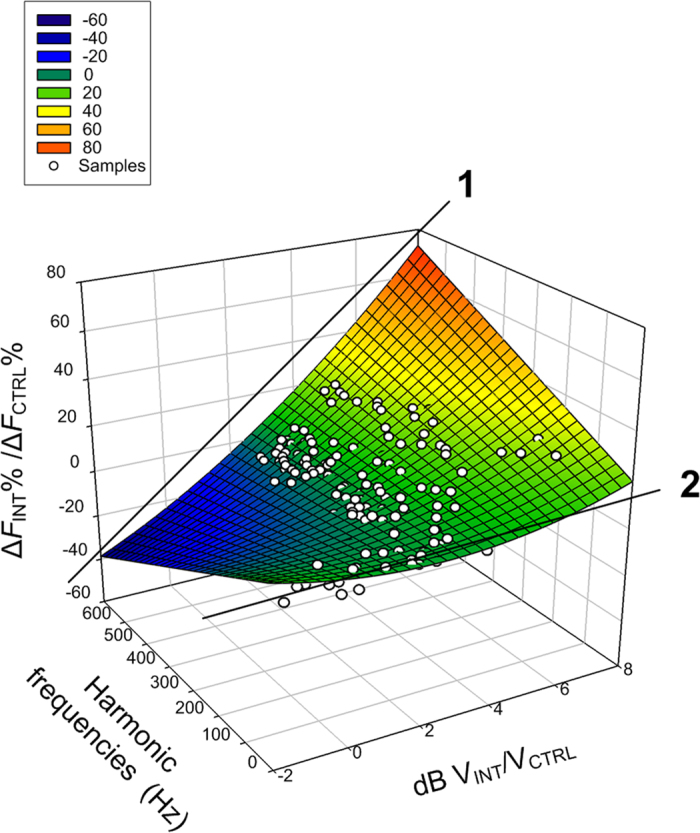
Samples (n = 240) of the INT/CTRL ratios at the stimulation frequency and harmonics (20–600 Hz) were fitted into a 3-D surface derived from a regression model.All coefficients of the regression model were significant (p < 0.0001). The colors correspond to the ΔFINT%/ΔFCTRL% axis. Line 1 indicates that higher correlation occurs at higher frequency whereas line 2 indicates that lower correlation occurs at lower frequency.